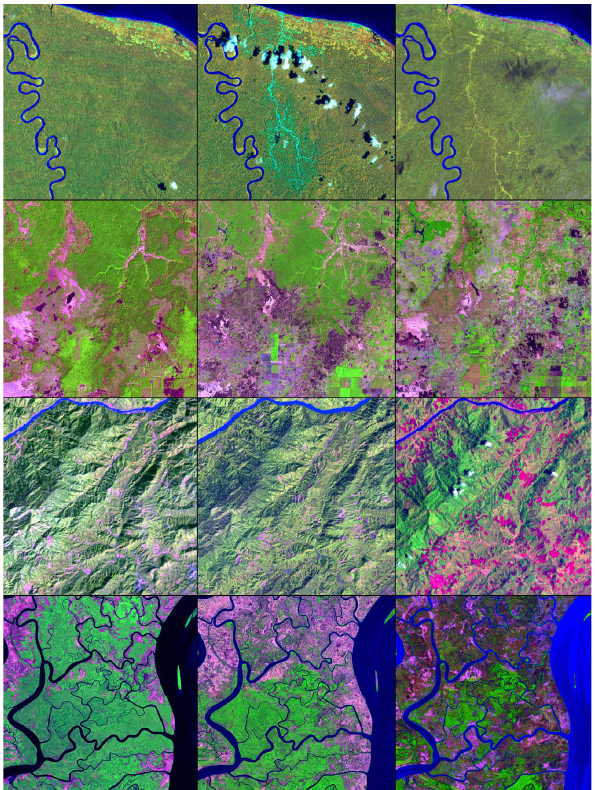
Fig. 5. Examples of forest change patterns from insular Southeast Asia, taken from Landsat TM/ETM imagery for 1990–2000–2010 for selected sample units. Top row, site S03-E114, S-Kalimantan: conversion of former peat swamp forest to agriculture and oil palm; row 2, site N04-E117, N. Kalimantan: conversion of lowland forests to oil palm plantations; row 3, site N03-E113, N. Sarawak: planta- tion establishment of fast-growing trees for pulp and paper; bottom row, site S08-E147, PNG: impact of fires.